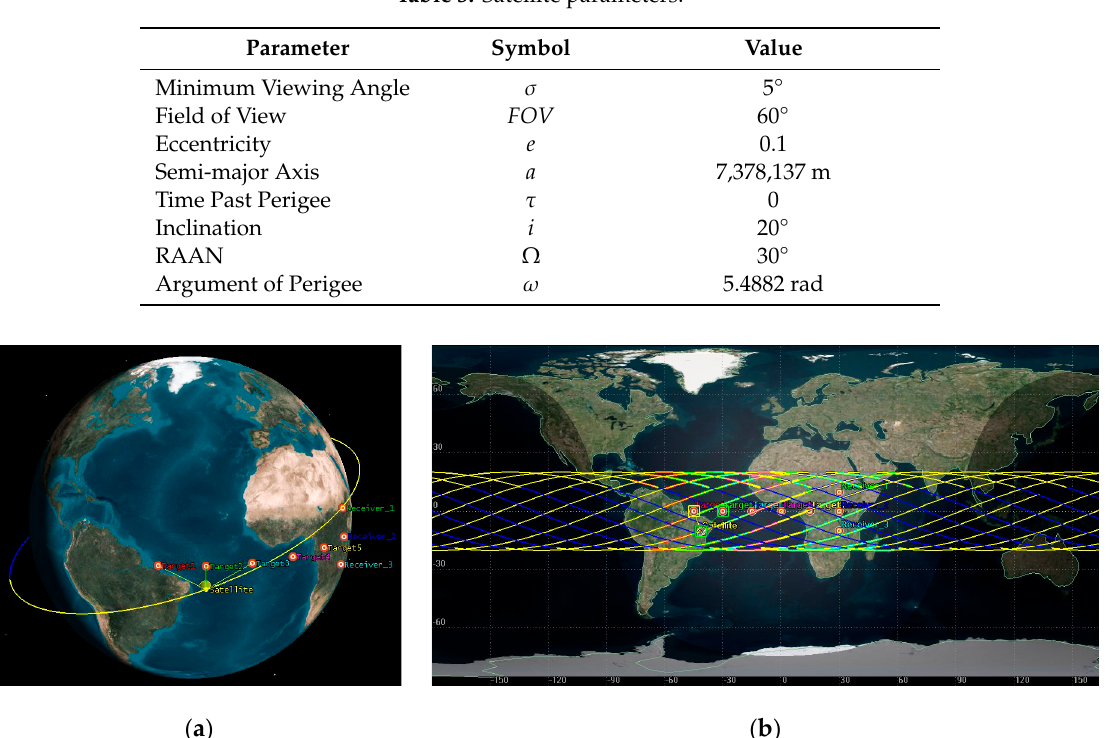
Table 3. Satellite parameters.